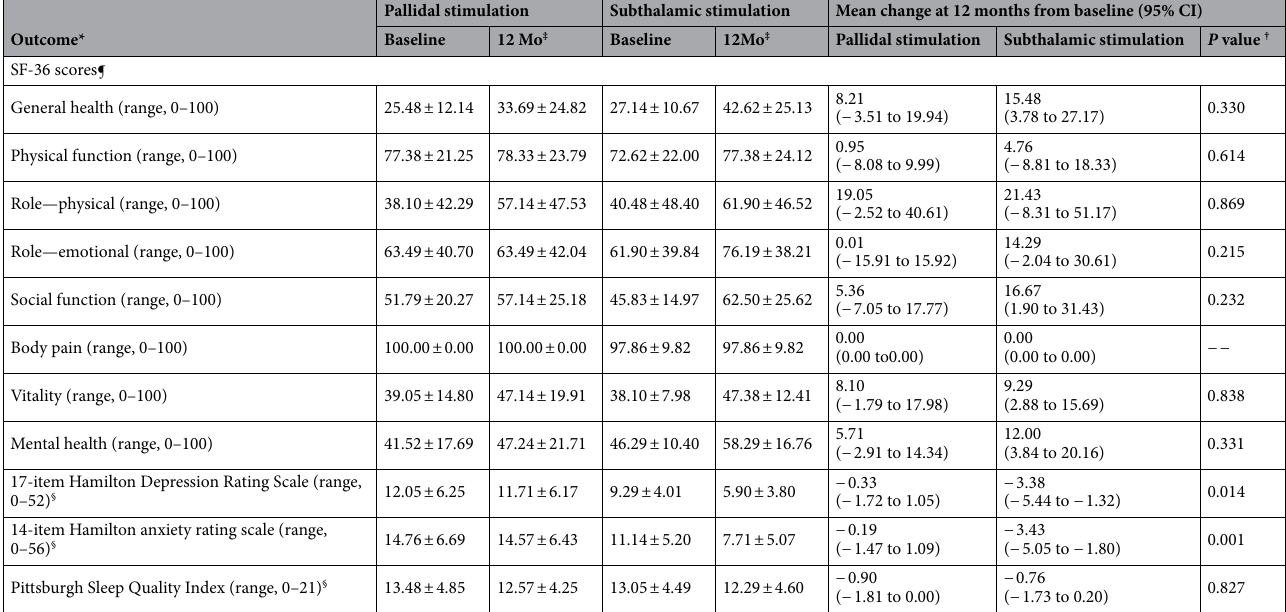
Table 5. Changes in Secondary Outcomes at 12 Months. *Plus–minus values are means ± SD. † P value s are for changes in scores from baseline to 12 months in the group undergoing pallidal stimulation, as compared with those undergoing subthalamic stimulation. ‡ Assessments with DBS on. § A higher score indicates worse functioning. ¶ A higher score indicates better